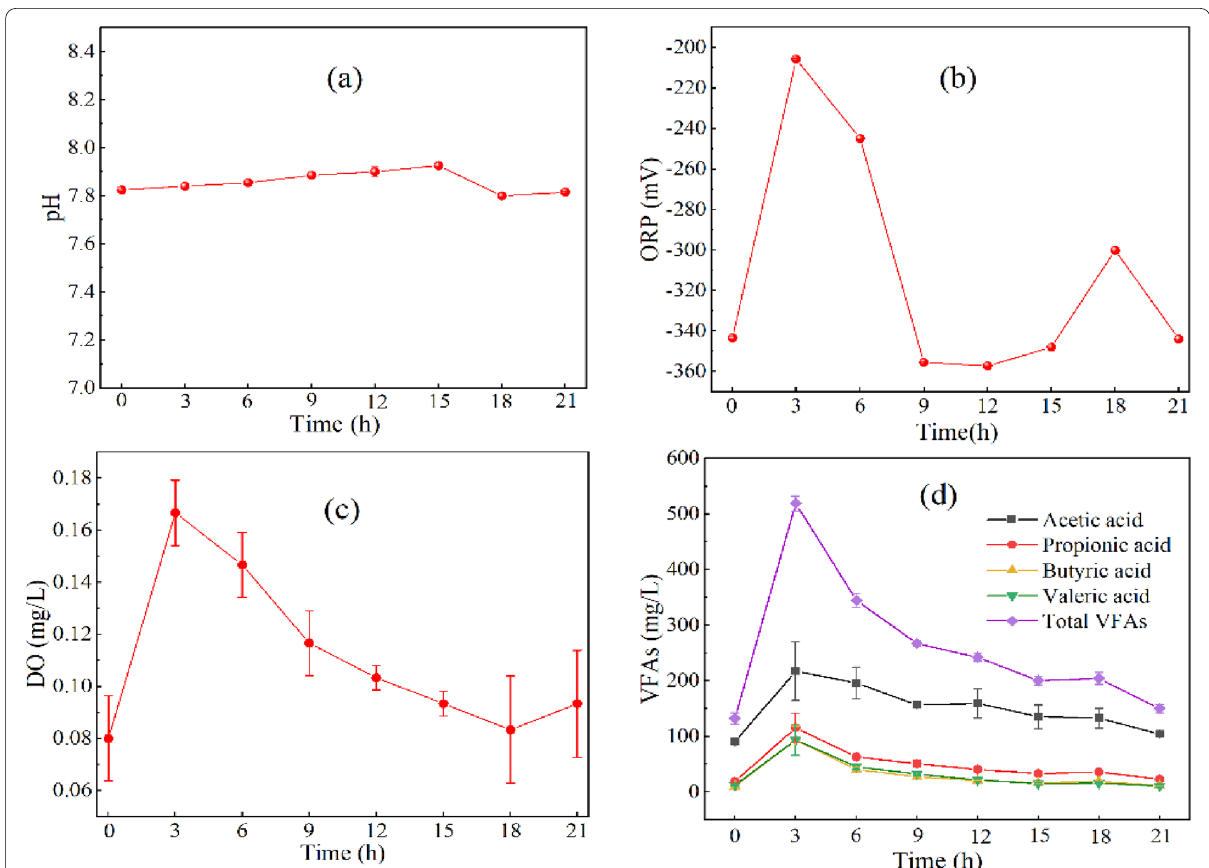
Fig. 3 Characteristics of pH, ORP, DO, and VFAs within the anaerobic fermentation of pig manure with a high solid. a pH; b ORP; c DO; d total